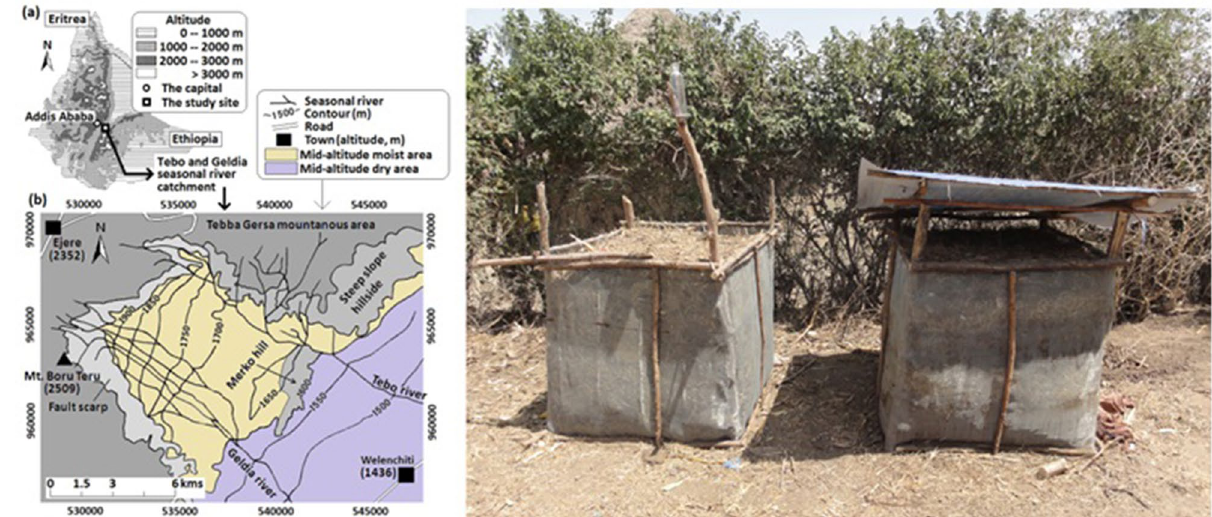
Figure 1. The study area (left figure) and the test- kosi pile (left in the right figure) and the fast compost pile (right in the right